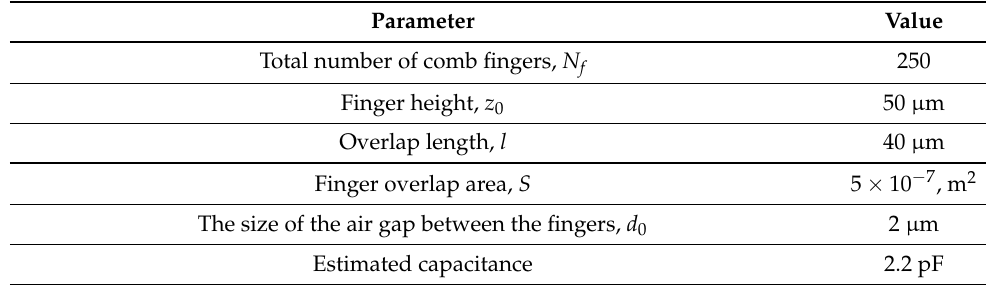
Table 1. Design parameters of the capacitive element of the SE.